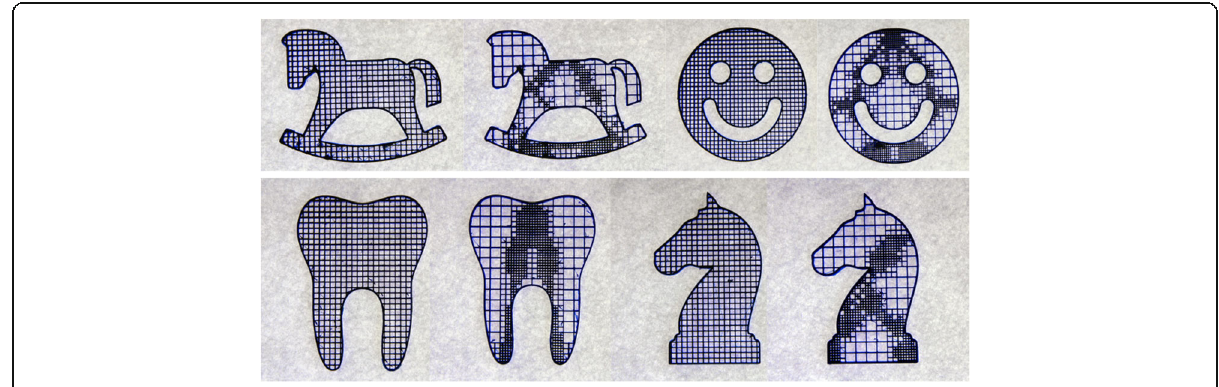
Fig. 9 The 3D printing results after topology optimization [24]